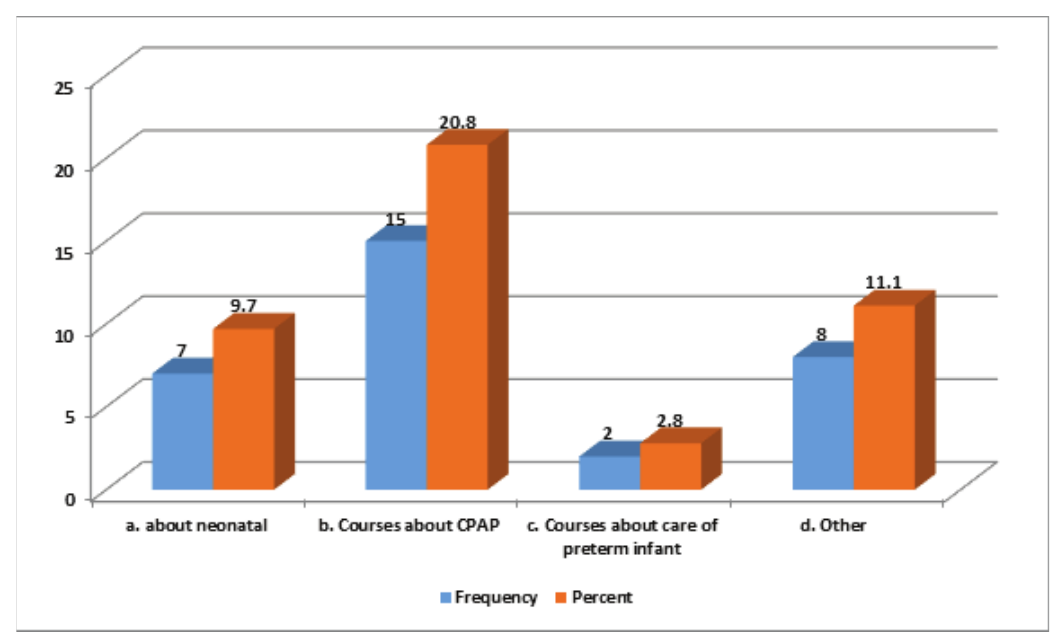
Figure 1: Distribution of the study samples according to their knowledge regarding the training courses. TABLE 2: Distribution of the study samples according to their knowledge regarding the common complication of prematurity ( N =